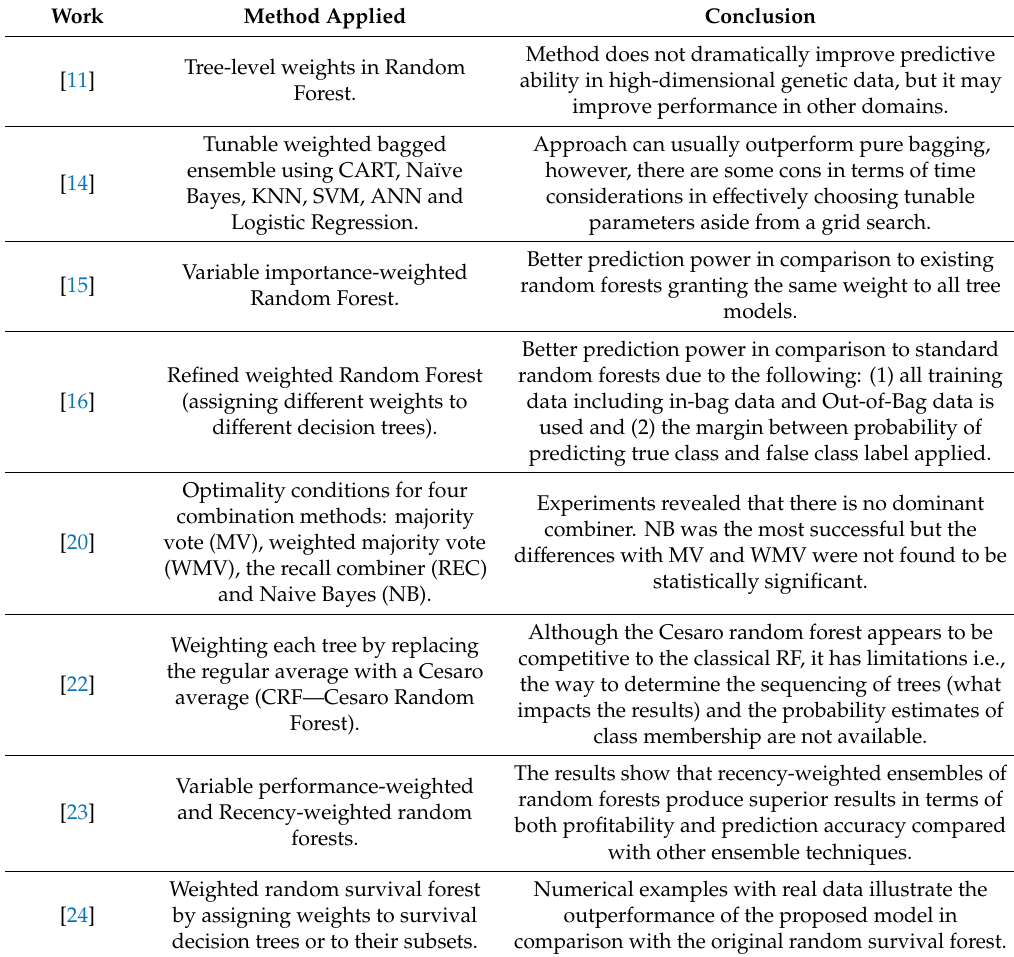
Table 1. Weighting methods for ensemble classifiers in the